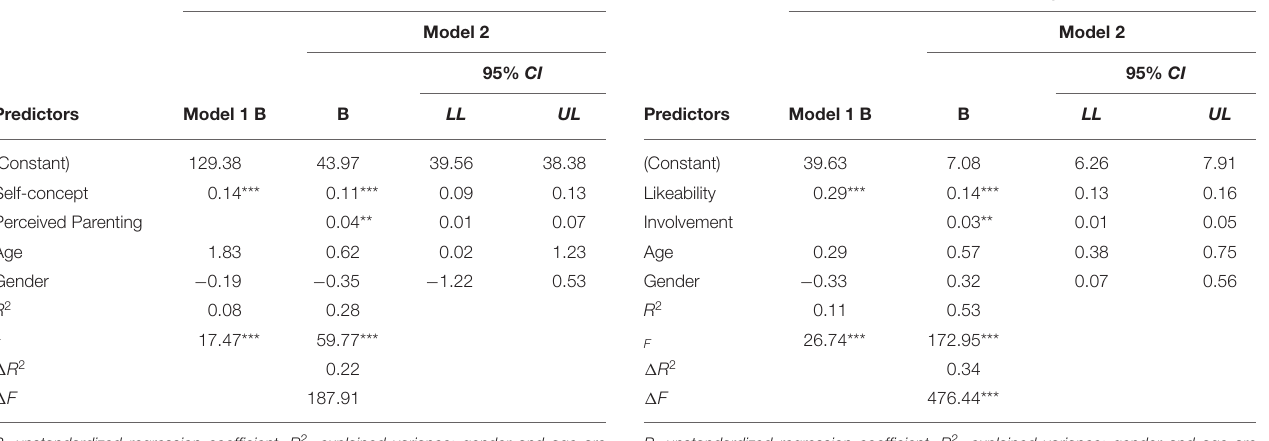
Frontiers in Psychology |